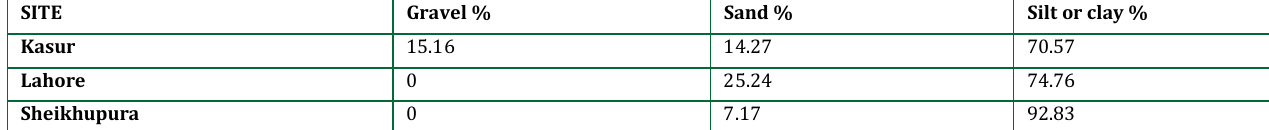
Table 4: Comparison of Grain Size Analysis